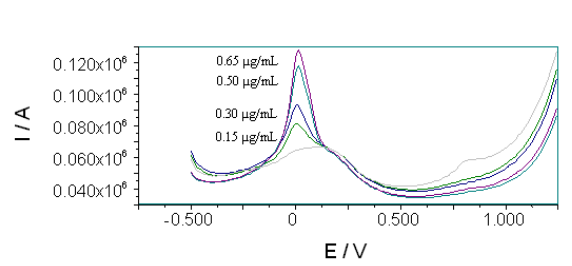
Figure 3: Differential pulse anodic stripping voltammograms obtained for determination of Cu 2+ in mixture of BR buffer at pH 4.1 / ethylene glycol (100/1, v/v) on glassy carbon